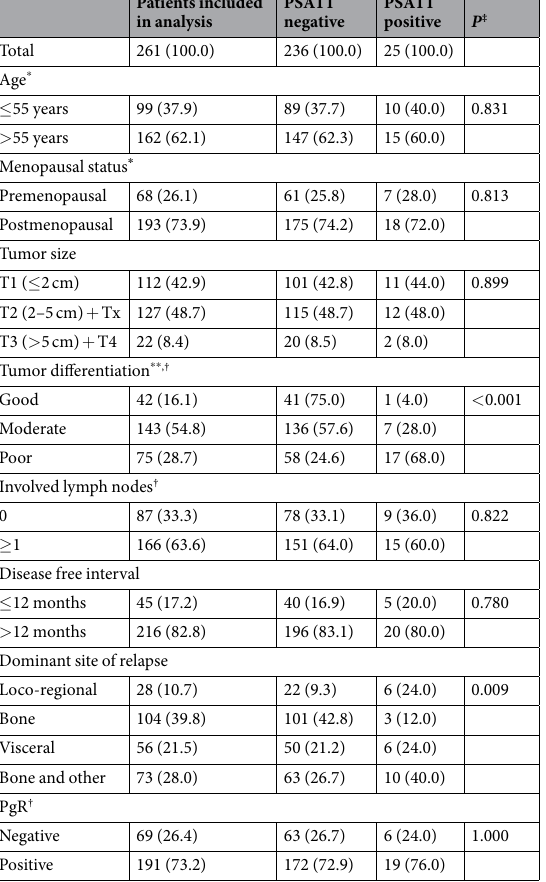
Table 1. Association of PSAT1 protein expression to clinical and histo-pathological characteristics. * Age and menopausal status were assessed at start of tamoxifen therapy. ** Tumor differentiation was evaluated through Scarff-Bloom-Richardson grading system. † Missing data not reported. ‡ PSAT1 association to clinical parameters was assessed by Fisher’s exact test (age, menopausal status, number of involved lymph nodes, disease free interval and PgR), χ 2 test (dominant site of relapse), and χ 2 test for trend (tumor size, grade). Acronyms: PgR: progesterone